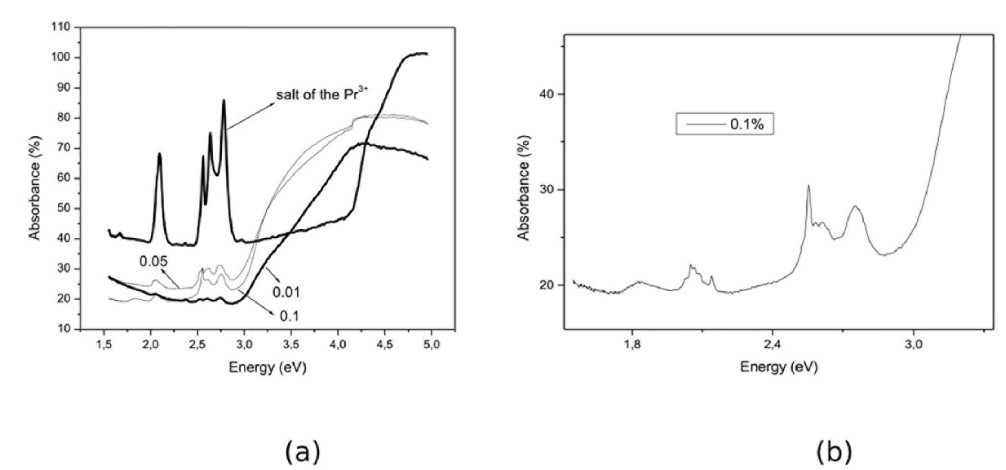
ZnTi O spinel doped with Pr 3+ (a)“L” and (b) a*. 2 3 8